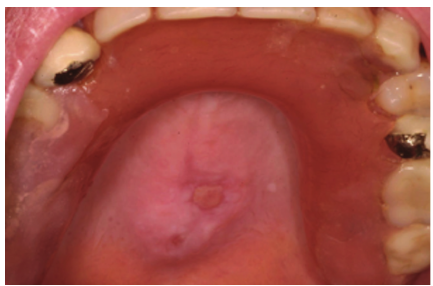
Figure 7: TP: suture being removed (7 days post-op), healing process is quite